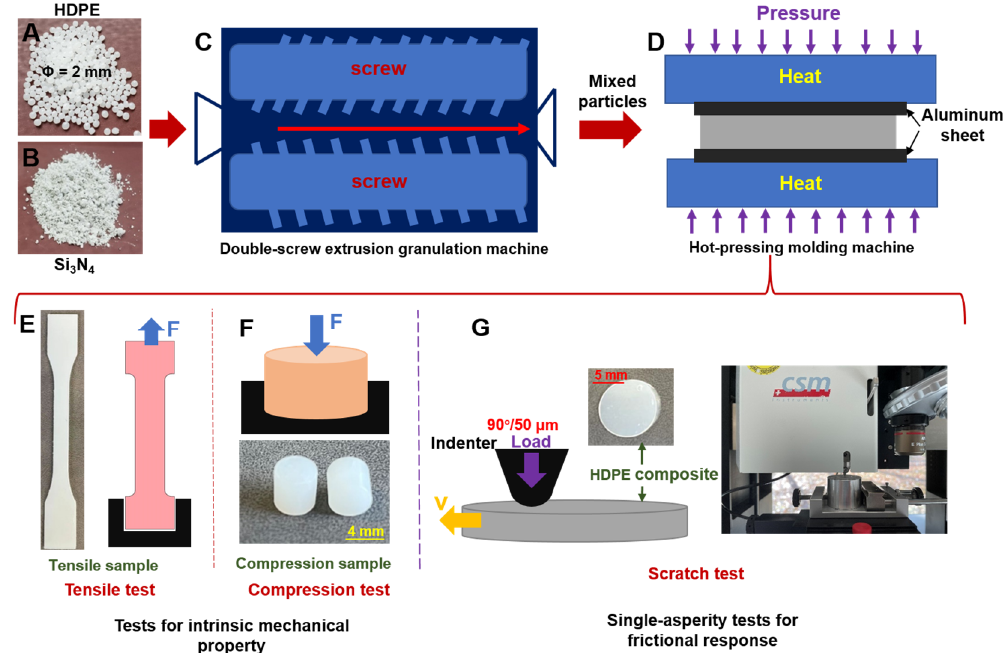
Figure 1. Sample preparation and testing apparatus: ( A ) HDPE granules; ( B ) silicon nitride powder (Si 3 N 4 ); ( C ) double-screw extrusion granulation for mixed particles; ( D ) hot-pressing molding machine for testing the samples. Tensile ( E ) and compression ( F ) tests for the intrinsic mechanical property. ( G ) Frictional response from the single-asperity scratching test.